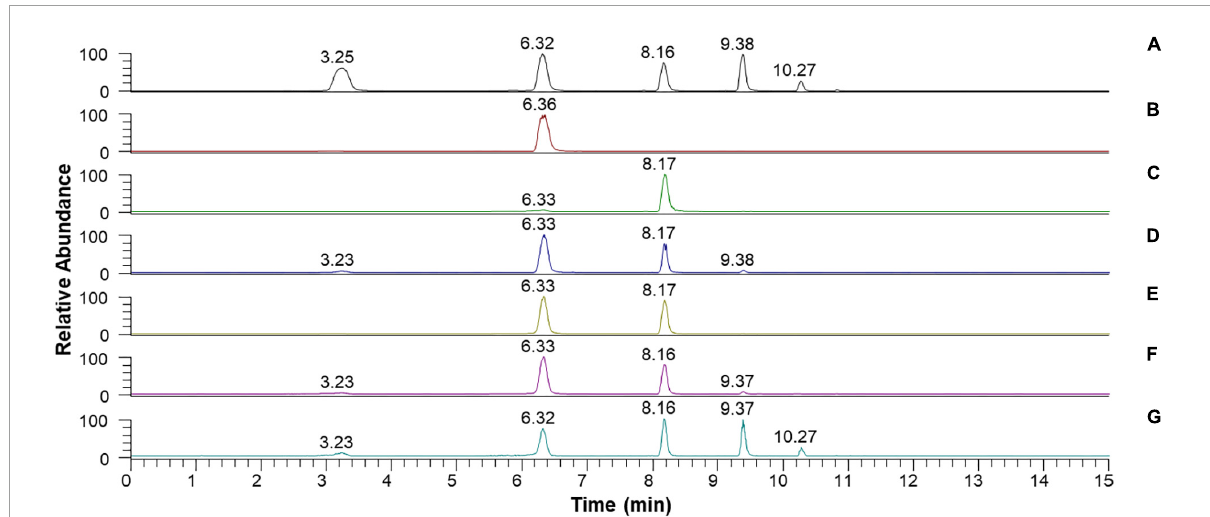
FIGURE7 Liquid chromatography (LC) analysis of the degradation products of D -cellooligosaccharides and CMC by recombinant endo- β -1,4-glucanase (rGluL): (A) total ion chromatogram of the standards [ D -glucose (C 1 : a peak with a retention time of 3.25 min), D -cellobiose (C 2 : a peak with a retention time of 6.32 min), D -cellotriose (C 3 : a peak with a retention time of 8.16 min), D -cellotetraose (C 4 : a peak with a retention time of 9.38 min), and D -cellopentaose (C 5 : a peak with a retention time of 10.27 min)]; (B) total ion chromatogram of the degradation products of C 2 ; (C) total ion chromatogram of the degradation products of C 3 ; (D) total ion chromatogram of the degradation products of C 4 ; (E) total ion chromatogram of the degradation products of C 5 ; (F) total ion chromatogram of the degradation products of C 6 ; (G) total ion chromatogram of the degradation products of CMC.